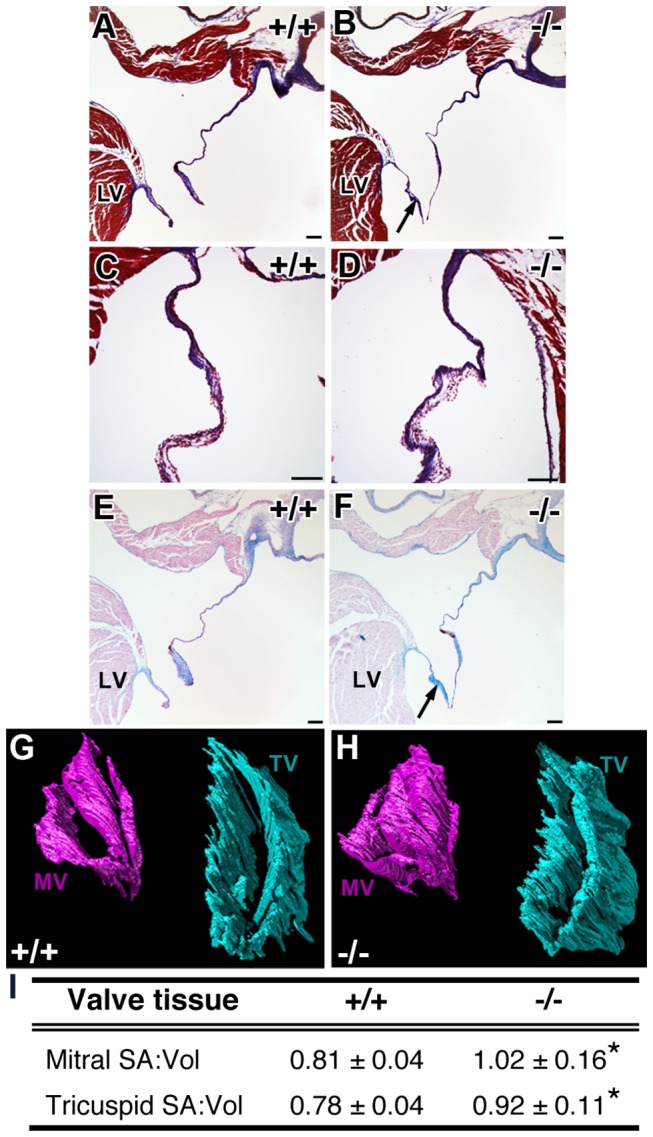
Atrioventricular valves of adult Pdlim7-/- mice display abnormal morphology.Histological sections from 3-month old WT and Pdlim7-/- hearts stained with Masson’s Trichrome (A-D) and Alcian blue (E-F) exhibit normal distribution of collagens (blue, A-D) and glycosaminoglycans (blue, E-F), but elongated mitral valves in Pdlim7-/- mice (arrows, B, F; n=5) compared to WT controls (A, E; n=3). Scale bar = 100 μm. Representative 3D reconstructions of serial sections of mitral (pink) and tricuspid (turquoise) valves from a WT (G) and Pdlim7-/- (H) mouse in the same anterodorsolateral perspective. Table providing quantification of increased surface area to volume ratios of atrioventricular valves in Pdlim7-/- (mitral, n=5; tricuspid, n=4) compared to WT (mitral, n=6; tricuspid, n=5) controls (I). *p<0.04. LV = left ventricle; MV = mitral valve; SA = surface area; TV = tricuspid valve; Vol = volume.